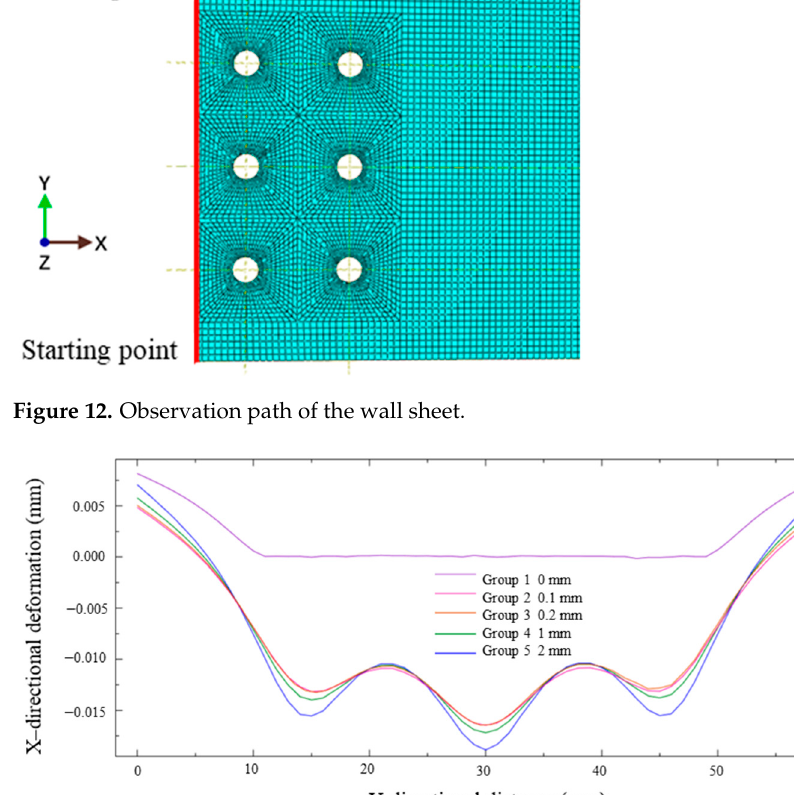
Figure 13. Boundary deformation of the wall sheet after riveting.